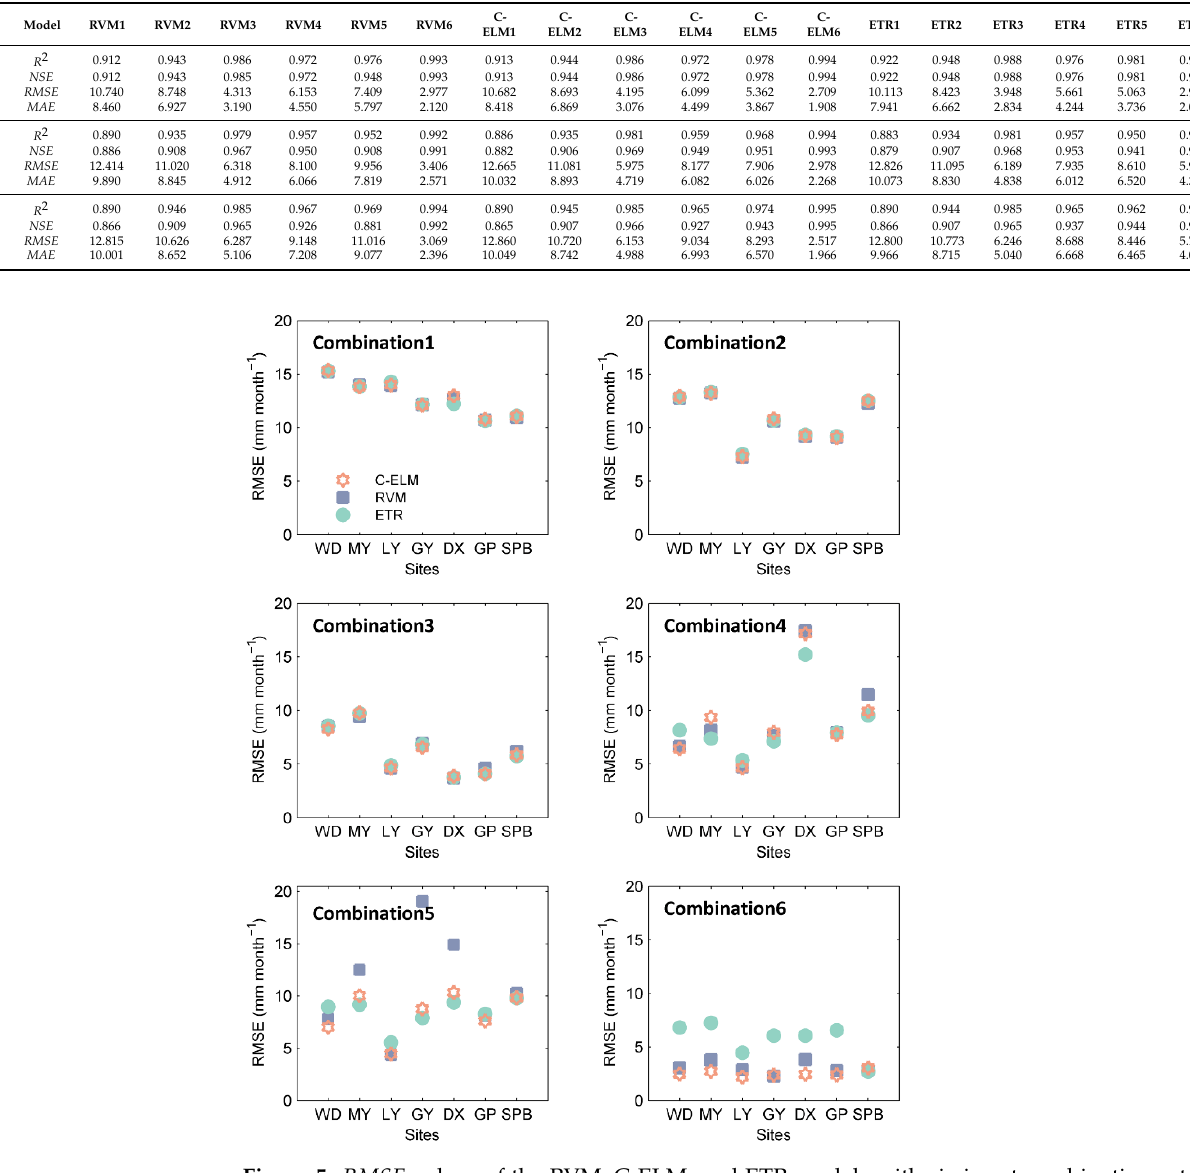
Figure 5. RMSE values of the RVM, C-ELM, and ETR models with six input combinations at the seven stations for modeling ET 0 during the testing period (2008–2014). WD-Wudu, MY-Mianyang, LY-Lveyang, GY-Guangyuan, DX-Daxian, GP-Gaoping, SPB-Shapinba.